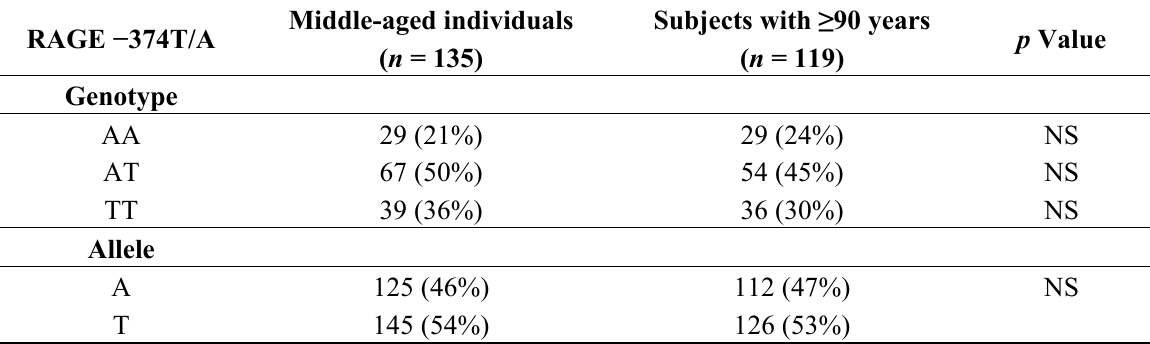
Table 2. − 374T/A genotype and allele frequencies in middle-aged and long-living subjects. RAGE −